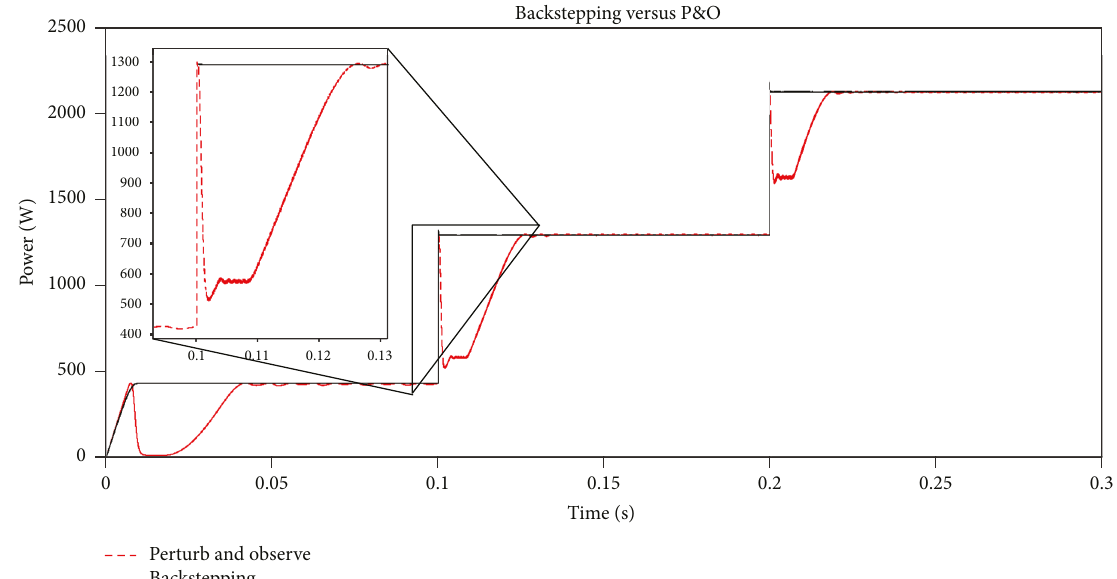
Figure 8: Power comparison under varying